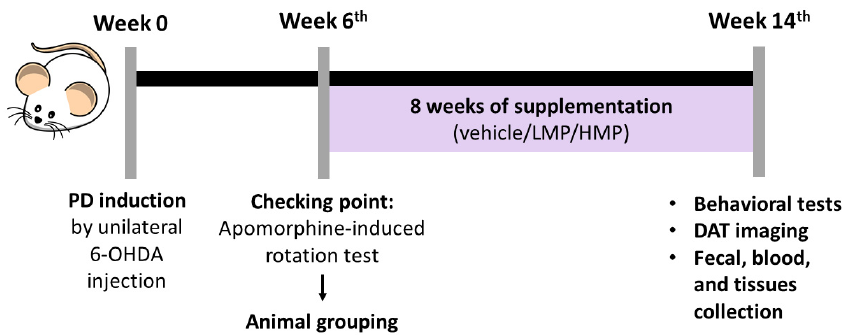
Figure 1. The timeline of the animal